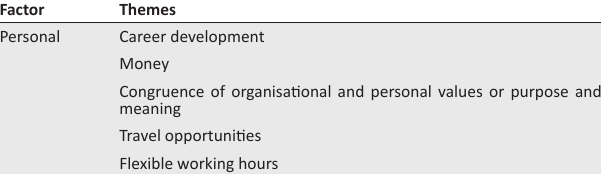
TABLE 5: Themes emerging from personal